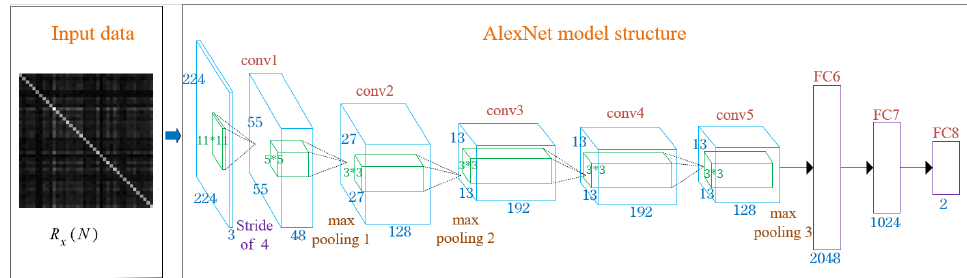
Figure 3. AlexNet model